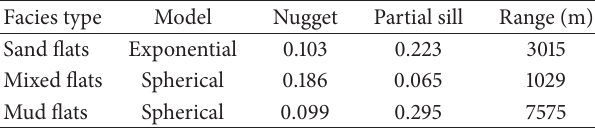
Figure 2: Ternary diagrams of three grain size components and sediment facies